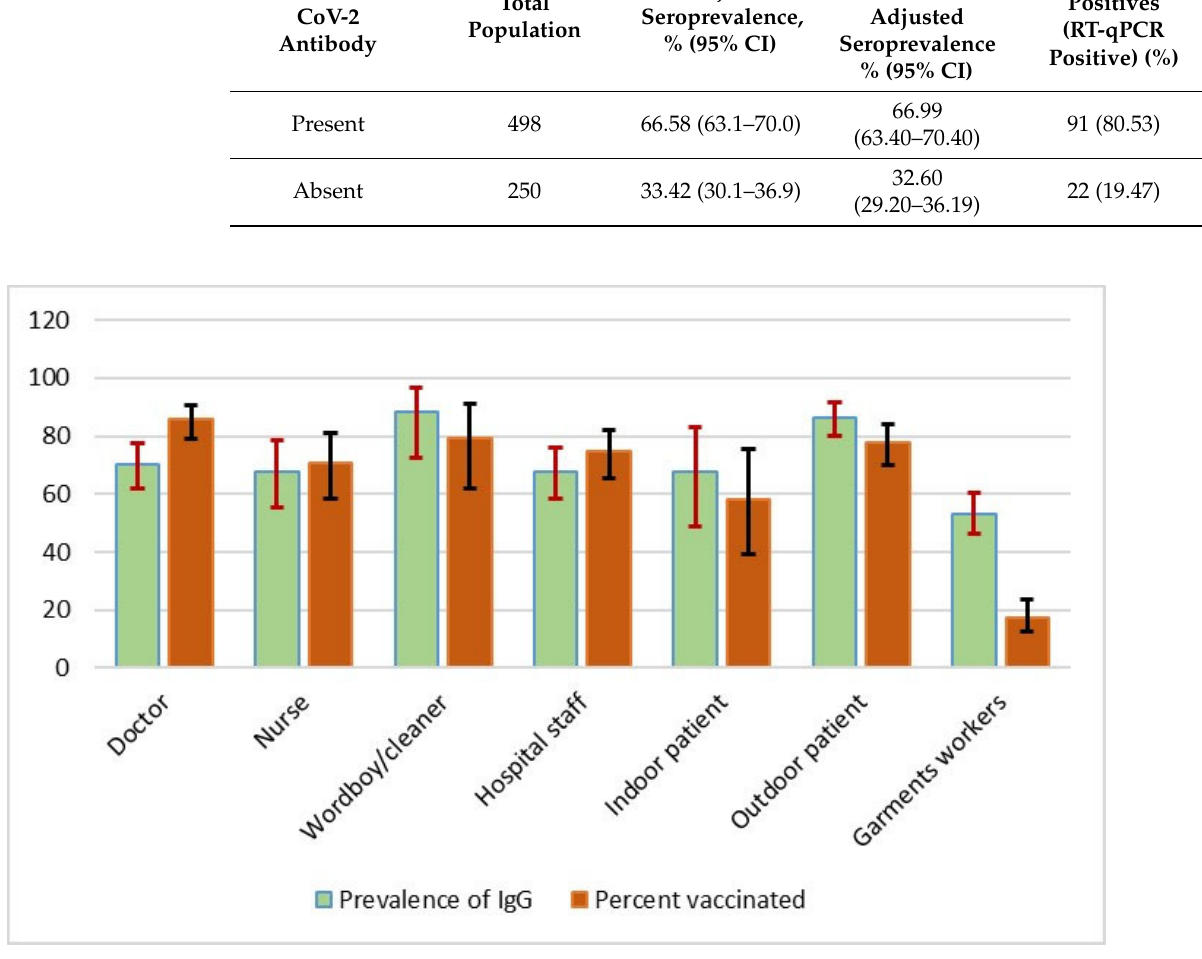
Figure 1. Prevalence of anti-SARS-CoV-2 antibody (IgG) in different donor types along with the vaccinated percent.